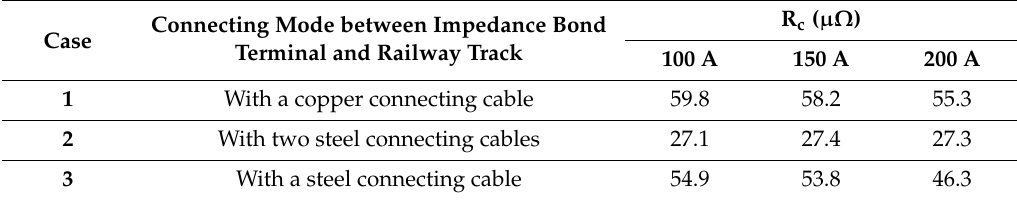
Table 3. Contact resistance values from the impedance bond